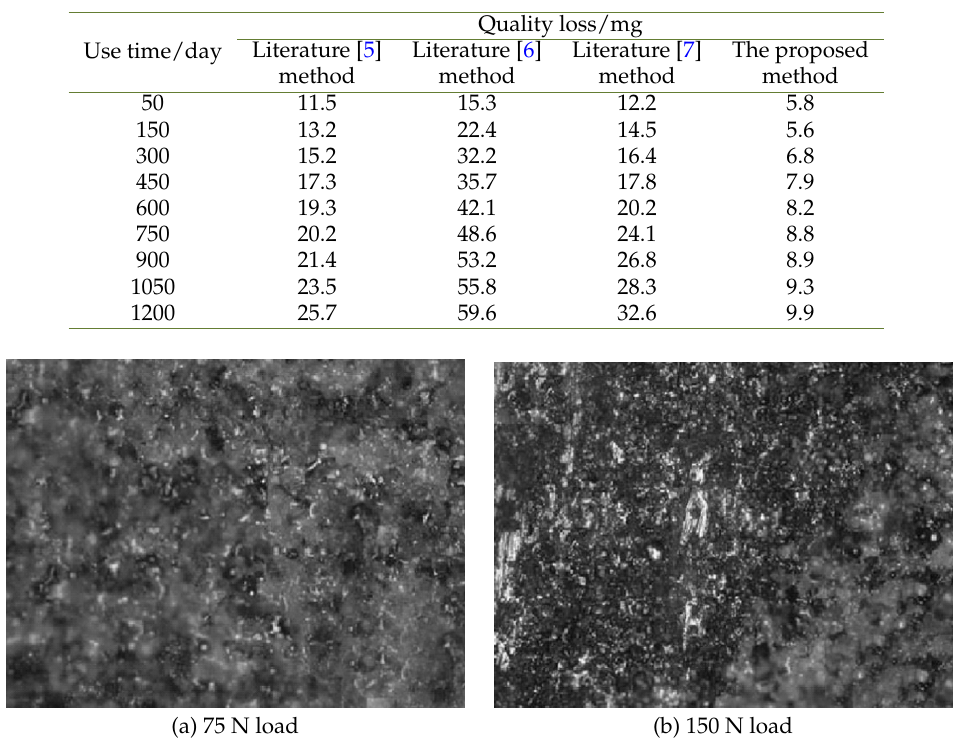
Fig. 7. Wear morphology of CoCrAlY-Al 2 O 3